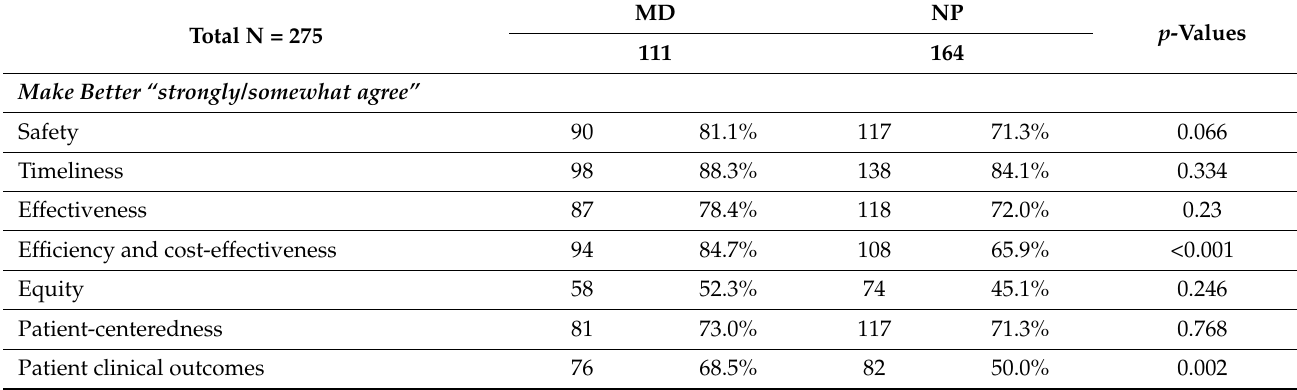
Table 4. Respondents’ Views on the Effect of an Increased Supply of Nurse Practitioners on the Quality of Healthcare.